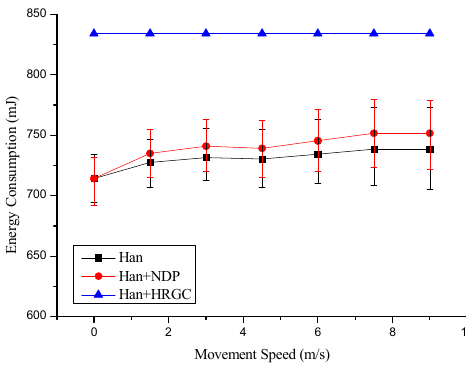
Figure 8. Energy consumption vs. movement speed of mobile devices.